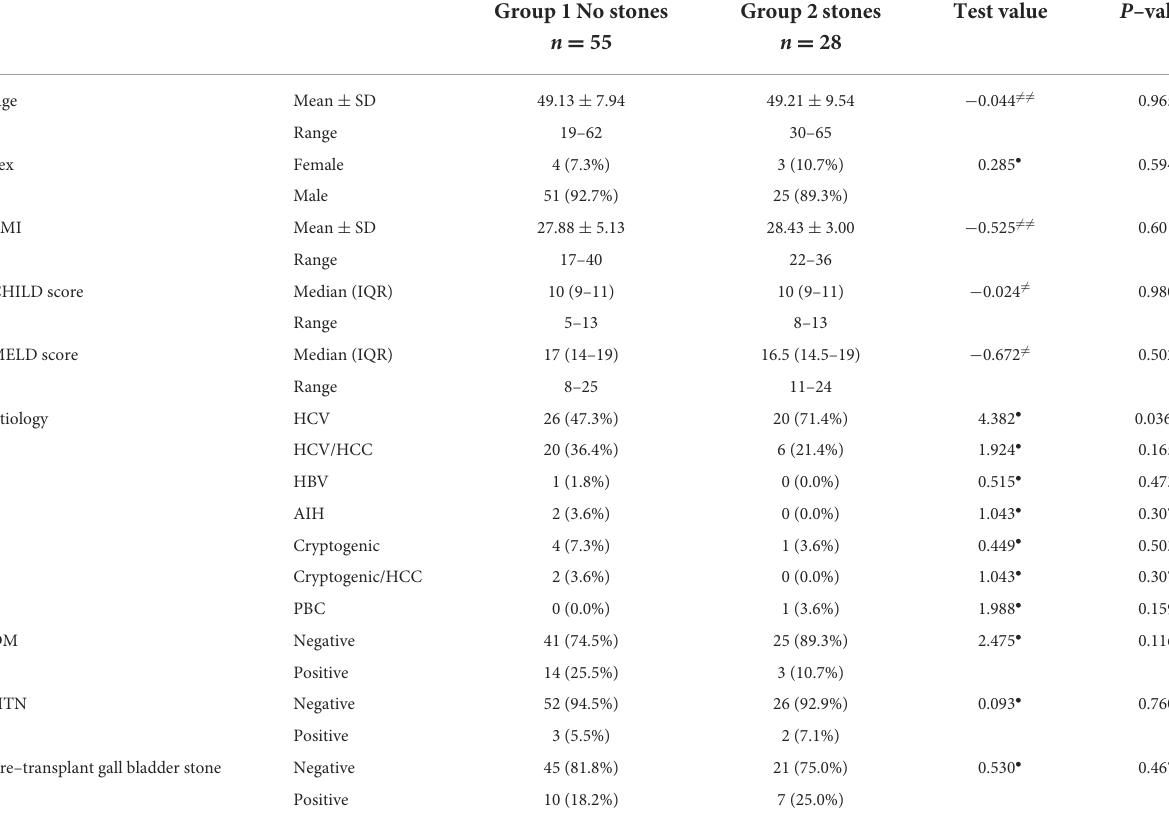
TABLE 1 Baseline characteristics of the study